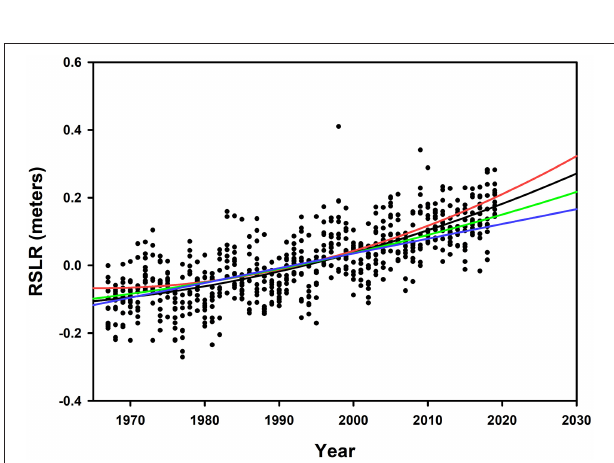
FIGURE 4 | Regressions of the upland to wetland conversion rate of the three upland ridges [West (triangles), main (open circles), and Canton (filled circles)]. West Ridge: ( y = − 5.04x 2 + 18,715x – 1,72,00,000 ), ( r 2 = 0.994 and p < 0.05 for all parameters). Main Ridge: ( y = − 30.4x 2 + 119133x – 11,70,00,000 ), ( r 2 = 0.97 and p < 0.05 for all parameters). Canton Ridge: ( y = − 552x + 11,30,000 ), ( r 2 = 0.991 and p < 0.05 for all parameters).